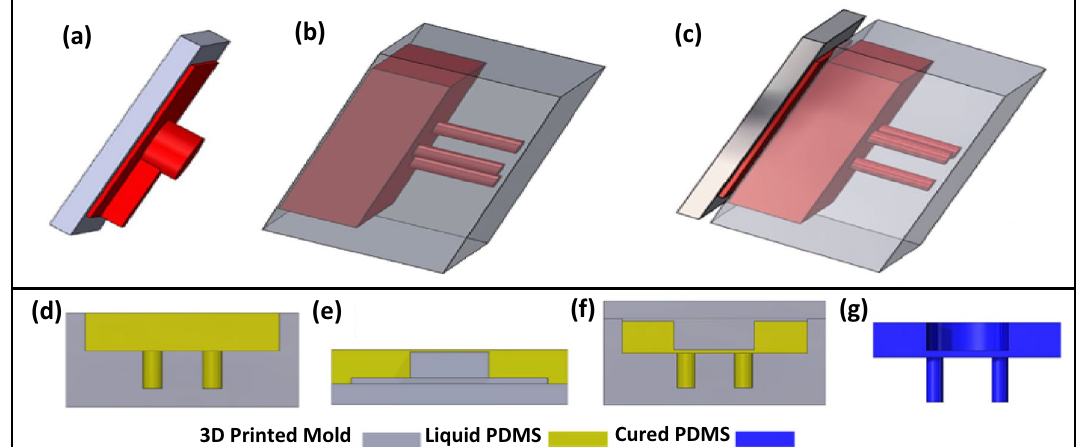
Figure 3. The schematic model for 3D printed molds and microgripper fabrication steps ( a , b ) The mold cap and mold for microgripper. ( c ) The closing main part and cap of the mold to shape the whole mold for the microgripper. The red color shows the internal surfaces of the molds. These surfaces will be in touch with the liquid PDMS and will shape microgrippers. ( d , e ) The 3D printed mold was filled with and de-bubbled liquid PDMS, and the mold cap was covered with the same PDMS. ( f ) Closing the mold and the mold cap. The liquid and de-bubbled PDMS were encapsulated in the 3D printed parts. As it can be seen, in this step the parts shown in ( d ) and ( e ) that filled and covered with PDMS are closed together to form the encapsulated area. ( g ) PDMS was cured at 25 °C in 1 week. The cured PDMS was removed from the 3D printed molds and the functional part of the microgripper was formed.